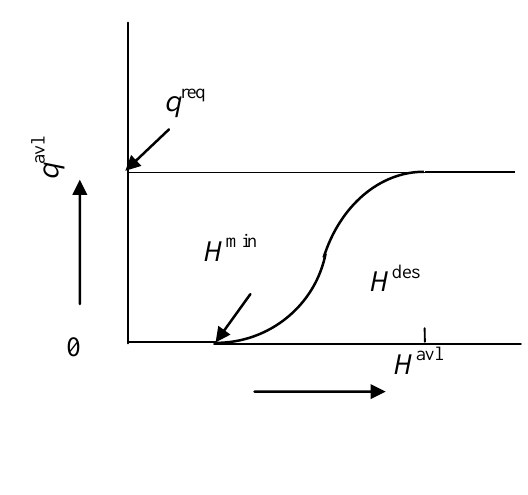
Fig. 4. Fujiwara & Ganesharajah